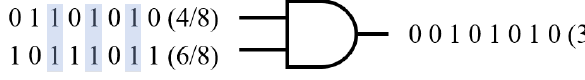
Figure 6. Example of stochastic multiplication.